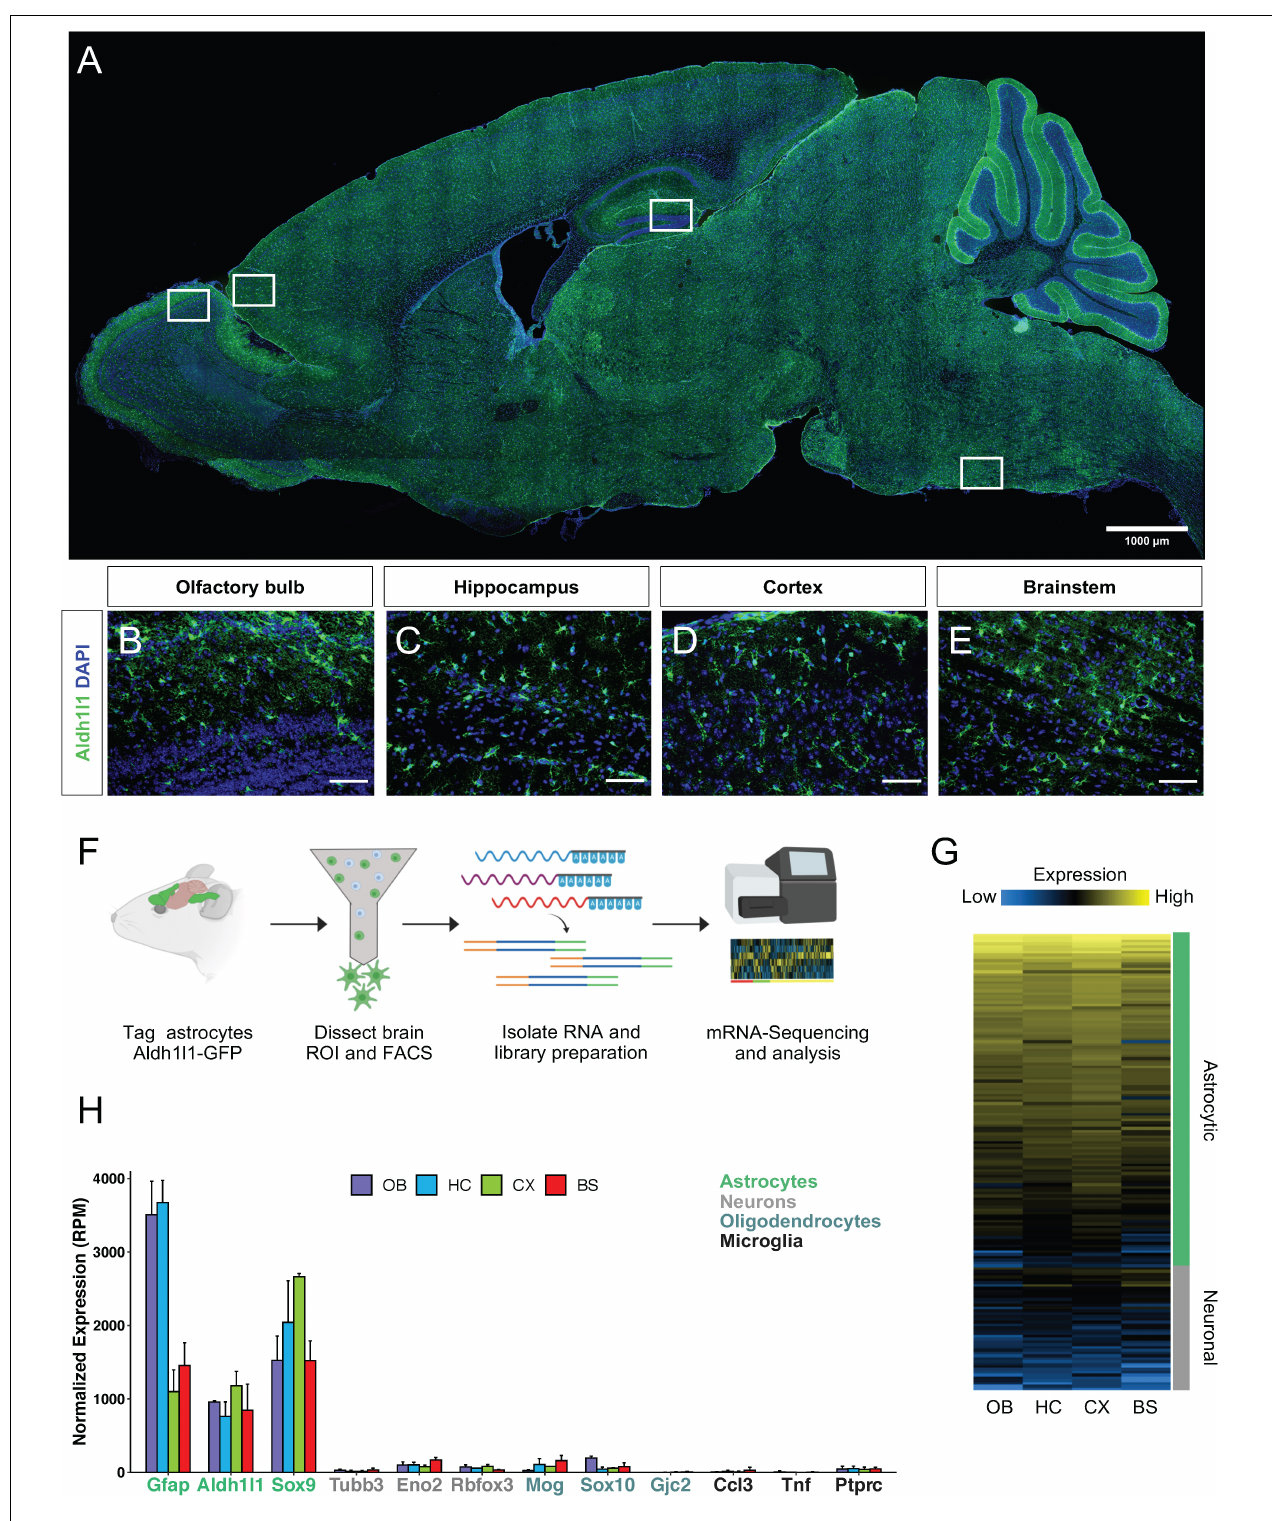
FIGURE 1 | Isolation and verification of Aldh1l1-eGFP astrocytes from selected regions. (A–E) Validation of Aldh1l1-eGFP cell specificity through immunofluorescence in, (A) whole brain, (B) olfactory bulb, (C) hippocampus, (D) cortex, and (E) brainstem. (F) Schematic of the approach used to investigate astrocyte regional diversity in the adult mouse brain. (G) Validation of cell identity through normalized expression of astrocyte and neuron specific genes. (H) Gene expression levels (in reads per million; RPM) of markers for astrocytes, neurons, oligodendrocytes, and microglia. Scale bar = 100 µ m. OB, olfactory bulb; HC, hippocampus; CX, cortex; BS,